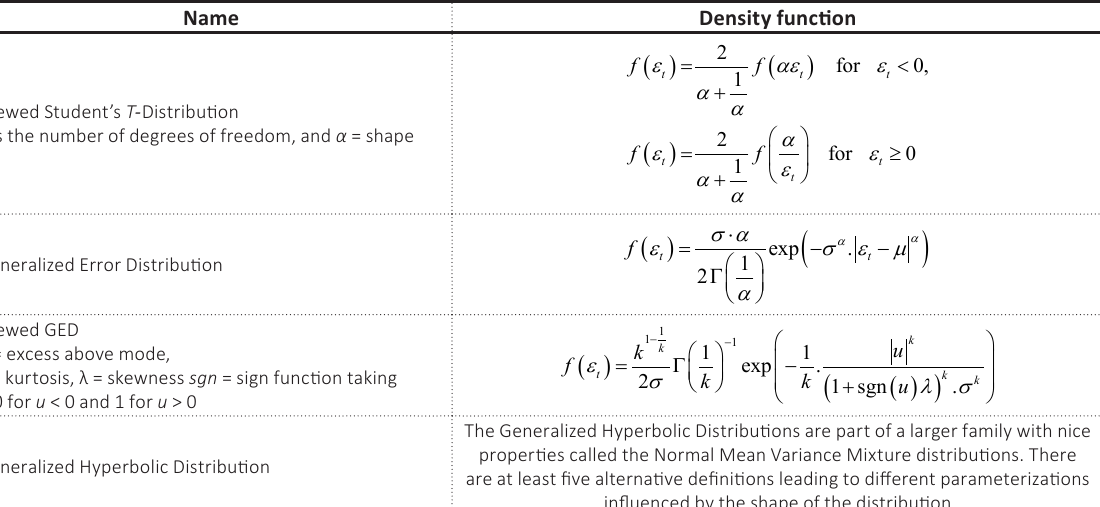
Table 1 (cont.). Error distribution